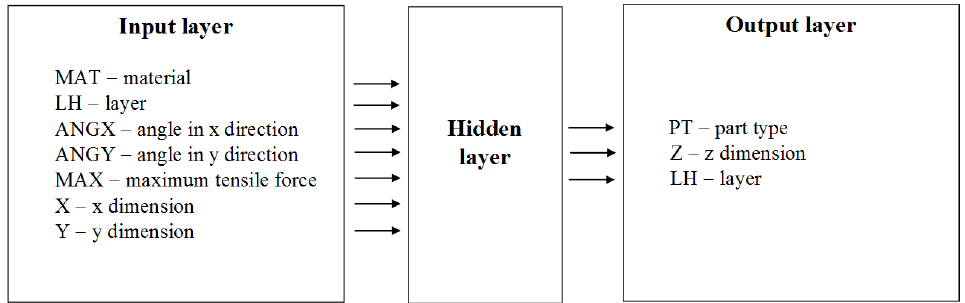
Figure 1. ANN structure: inputs and outputs.